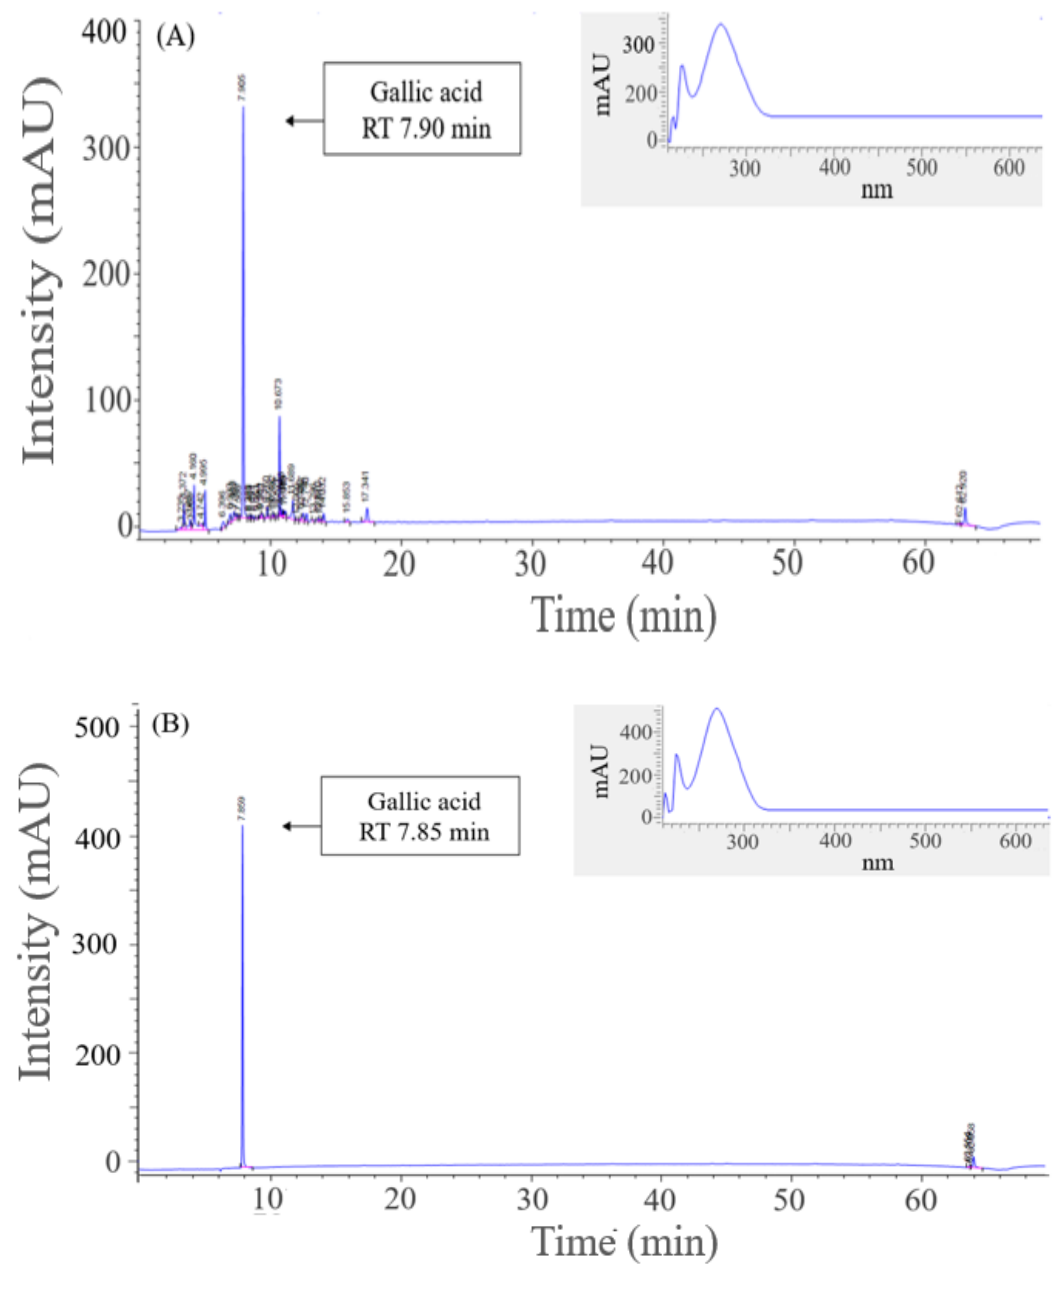
Figure 5. HPLC analysis for the quantitative analysis of main substances and polyphenols in C. gladiata extract. ( A ) chromatogram and DAD spectrum of C. gladiata extract, ( B ) chromatogram and DAD spectrum of gallic acid.